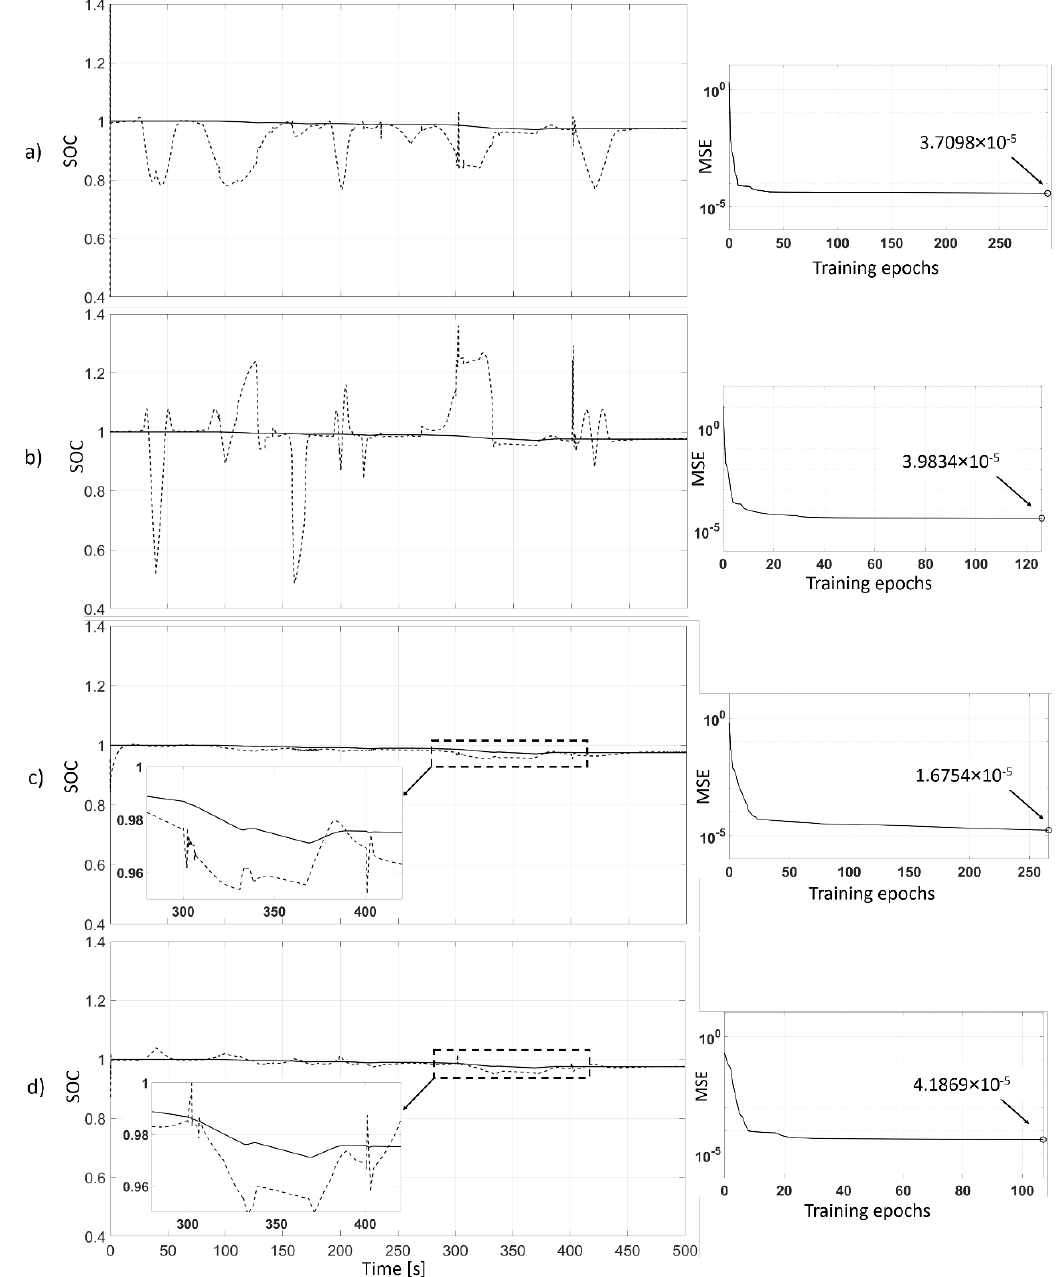
Figure 6. Performance of the first four proposed architectures. ( a ) Feedforward Linear Input-Output. ( b ) Multi-Layer Cascade Feedforward. ( c ) Recurrent Elman ANN. ( d ) Multi-Layer recurrent ANN. The SOC estimation and Mean Square Error trend during the training process of each network are reported in the left-hand and right-hand column, respectively.